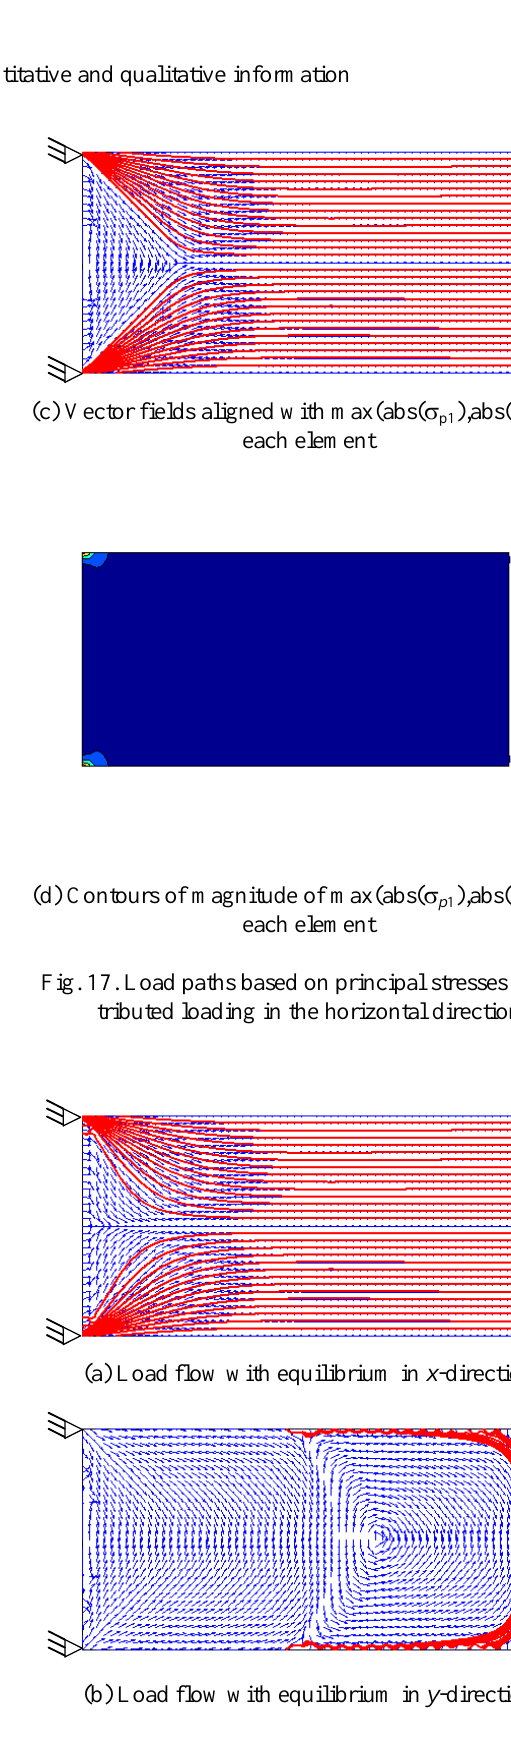
Fig.18. Orientation of load flow with distributed loading in the x